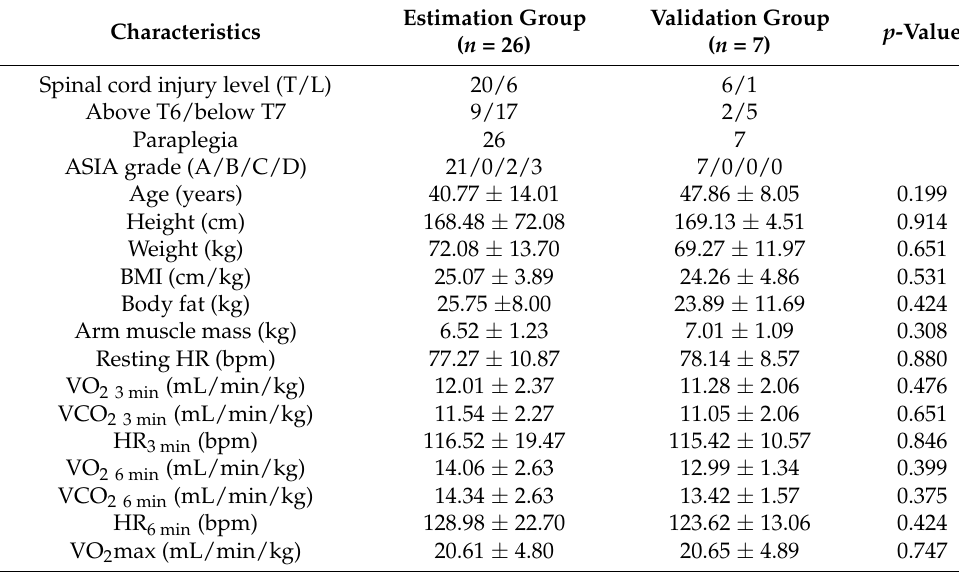
Table 1. Anthropometric and physiological characteristics of participants.